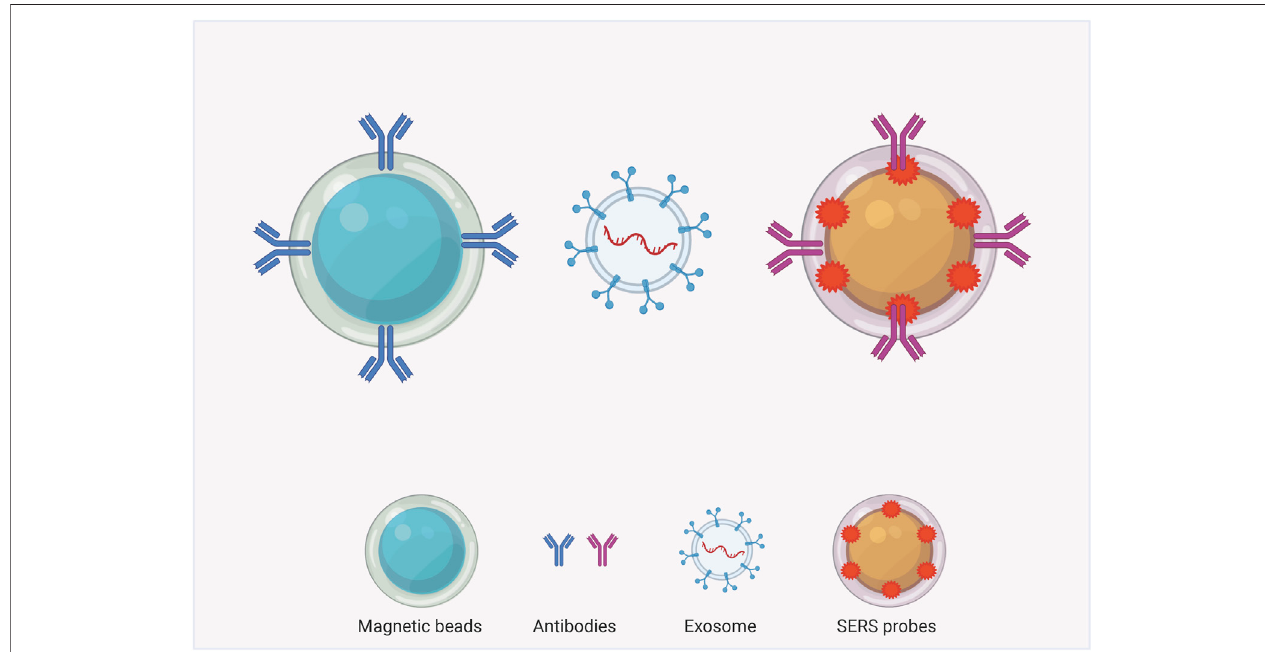
FIGURE 3 | Structural type diagram of exosome-magnetic bead-based SERS assay model.